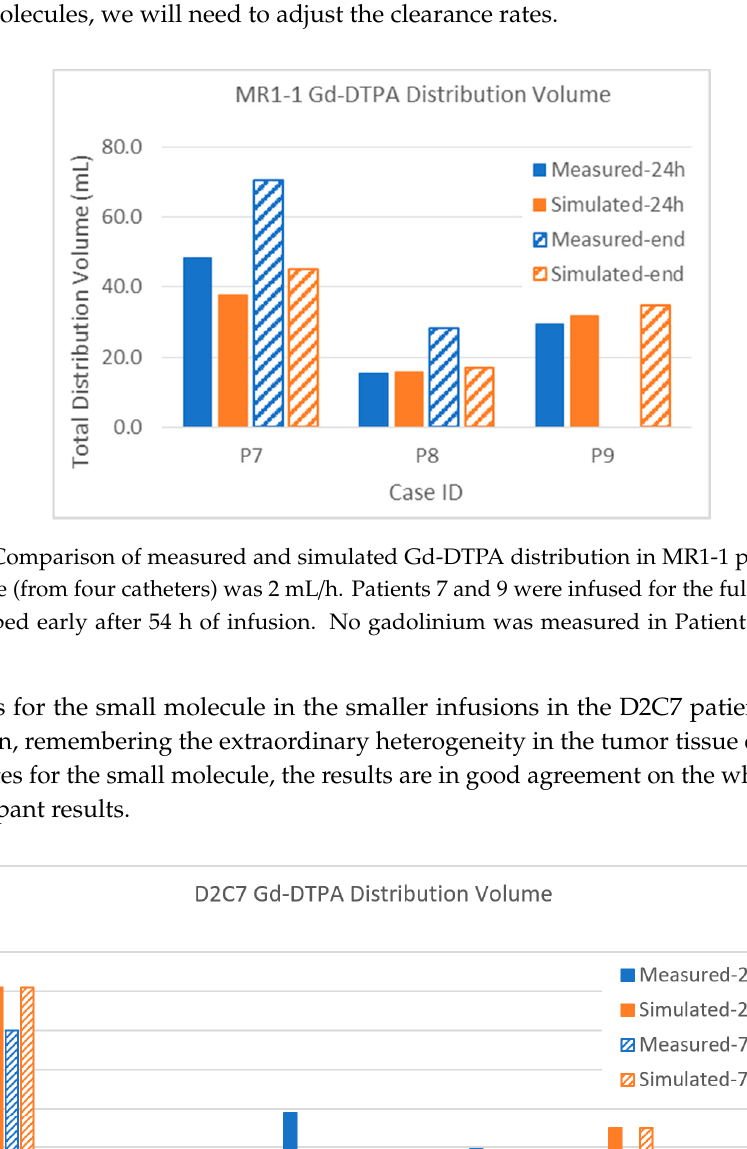
had a single catheter infused at 0.5 mL/h. The Patient 1025 24-h measurement is omitted because the